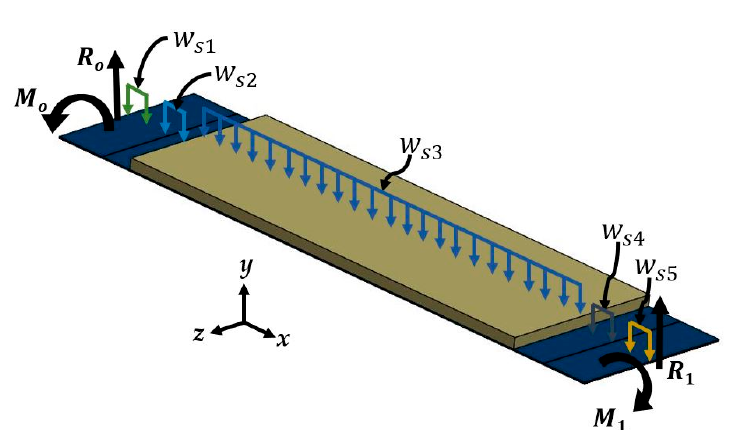
Figure 5. Schematic view of the different load types of the nanogenerator.